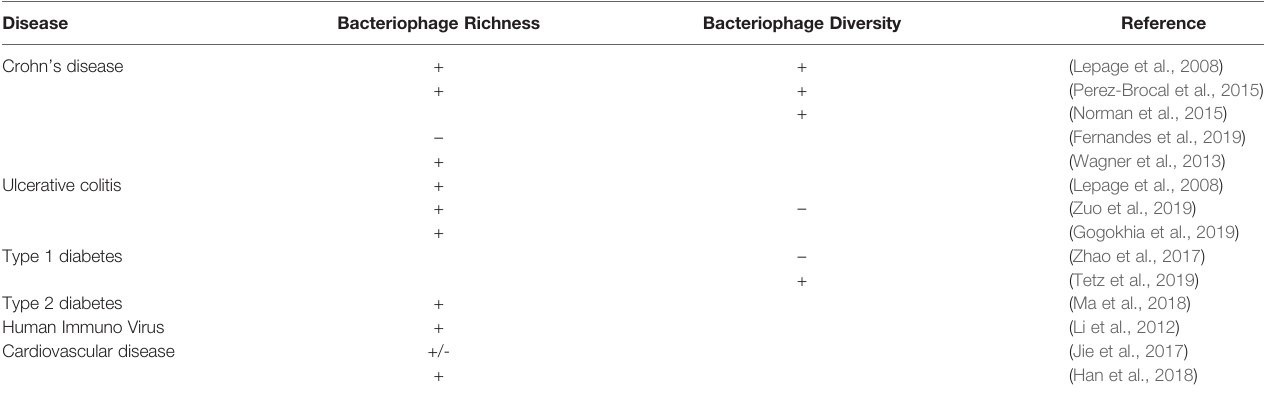
TABLE 6 | Summary of changes to the gut phageome in different disease